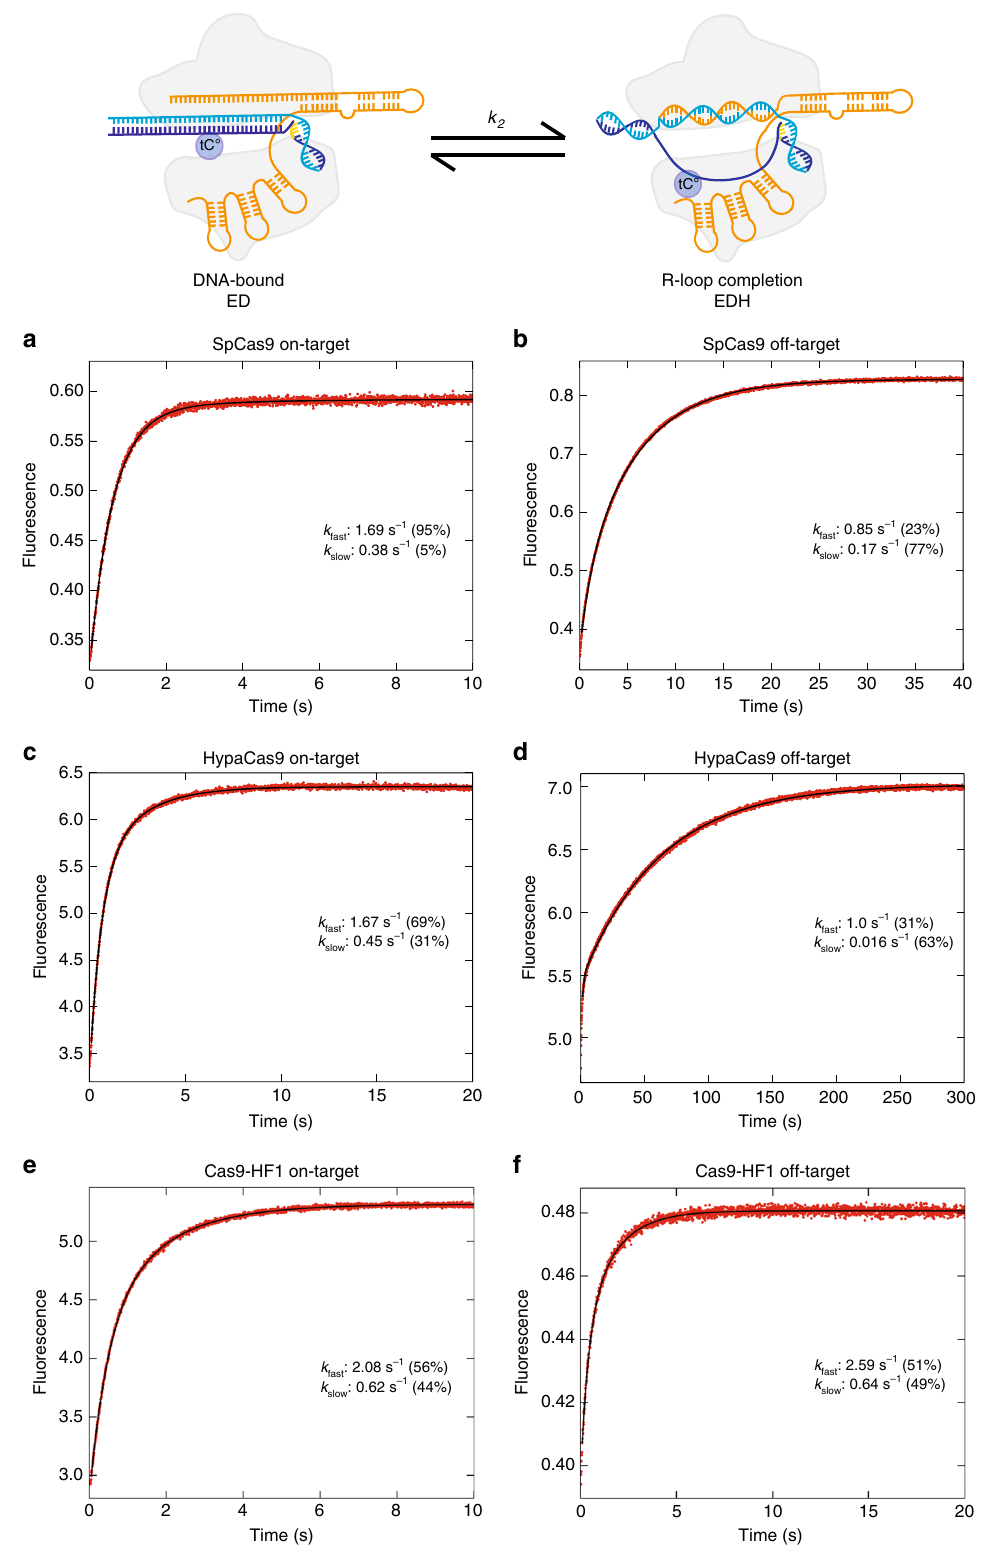
Fig. 2 DNA unwinding rates are nearly identical for on-targets and off-targets. R-loop formation decay rates were measured by the monitoring the fl uorescence increase from tC o (position − 16 in the non-target strand) as a function of time after mixing enzyme (28 nM) with DNA (10 nM) in the presence of 10 mM Mg 2 + . Data were fi t to a double exponential function to get the decay rates shown. a, b SpCas9 (28 nm) with on-target ( a ) and off- target ( b ) DNA, c, d HypaCas9 with on-target ( c ) and off-target ( d ) DNA. e, f Cas9-HF1 with on-target ( e ) and off-target ( f )